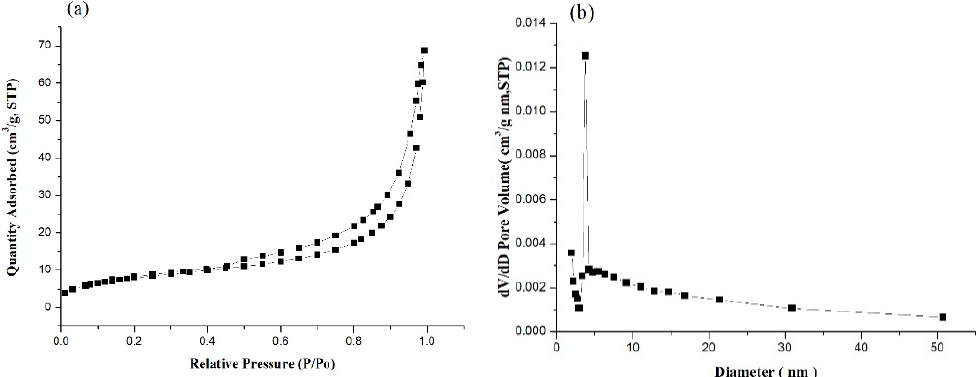
Figure 3. Nitrogen adsorption-desorption isotherm ( a ) and pore size distribution curve ( b ) of mesoporous iron particles.